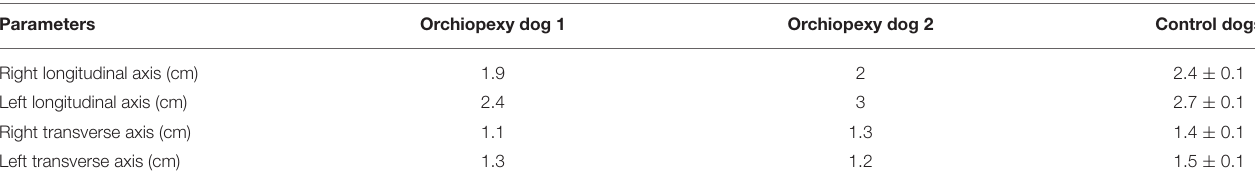
TABLE 1 | Lengths of the longitudinal and transverse axes of the right and left testicles in orchiopexy and control dogs.